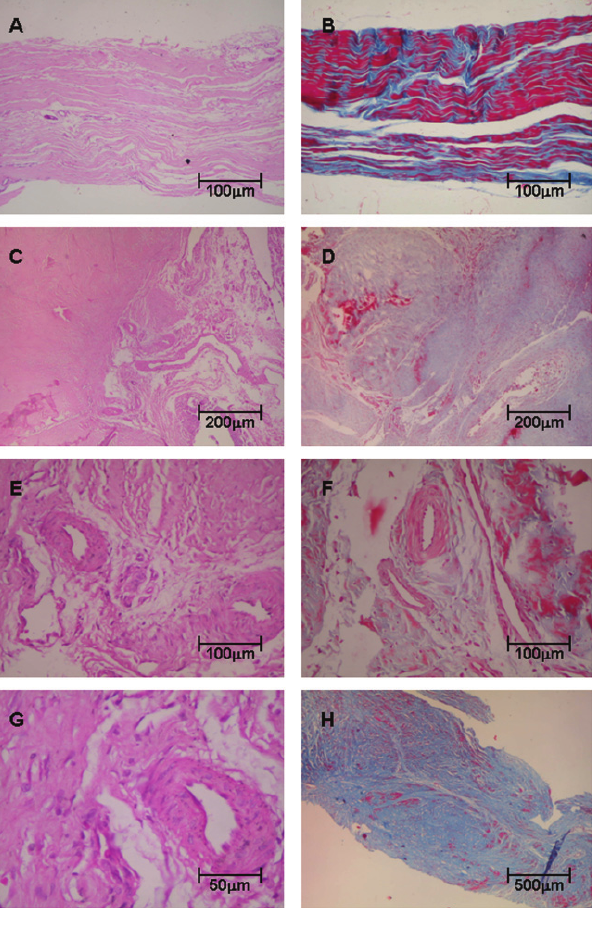
Figure 1 - Tendon samples obtained from control and posterior tibial tendon dysfunction (PTTD) patients, stained with Hematoxylin & Eosin (Panels A, C, E, G) and Masson’s trichrome (Panels B, D, F, H). Control tendons display normal architecture with parallel or linear orientation of collagen bundles and a low degree of vascularization (A) and (B). In contrast, (C) and (D) show tendon specimens from PTTD patients with architecture distortion and large pale areas with a wavy pattern of collagen bundles. In panels (E), (F) and (G), tendons from PTTD patients show increased vessels with complex branching caused by proliferation of fibroblasts and myxoid stroma. In (H), the final results of the remodeling process of tendonitis in PTTD are shown. (Original magnification: X 40 in panel H; X 100 in panel A, B, C, D and H; X 200 in panels E and F; X 400 in panels G) show distortion of the architecture and diffuse increase of birefringence for all three types of collagen. Type I